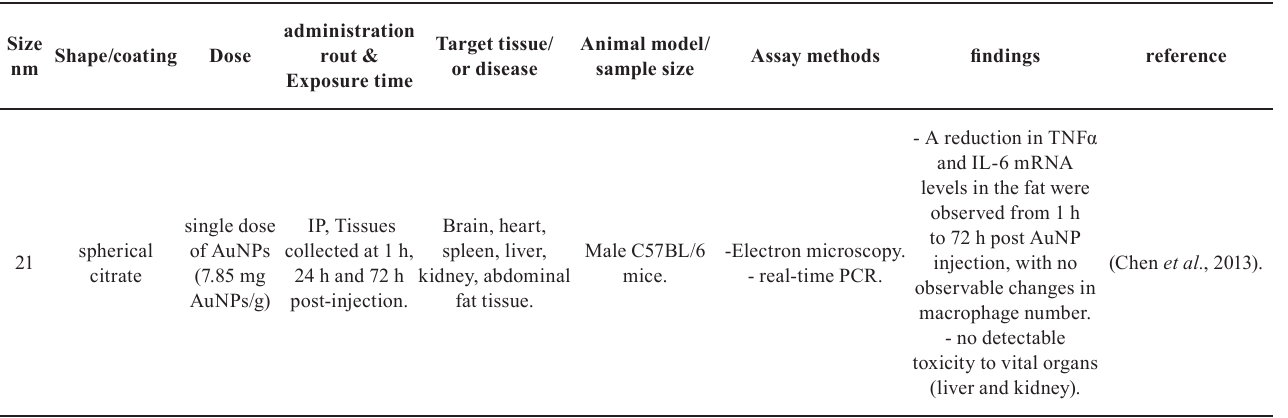
TABLE II – Therapeutic effects of Gold nanoparticles on different disorders